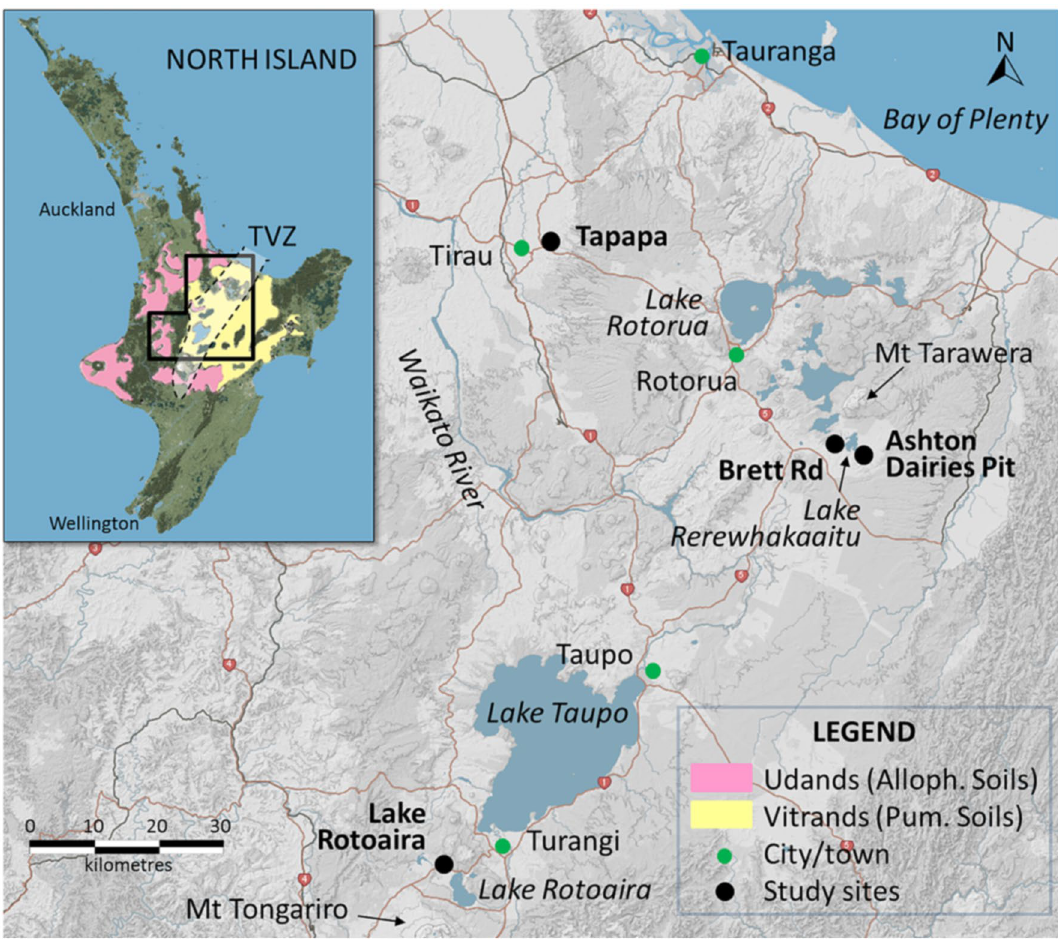
Figure 2. Map of central North Island, New Zealand, showing the locations of the four study sites in the Taupo- Rotorua region. The inset map shows the distribution of Andisols, mainly Udands (equivalent to Allophanic Soils in Hewitt 44 ) and Vitrands (equivalent to Pumice Soils in Hewitt 44 ), and the location of Taupo Volcanic Zone (TVZ) encompassing the volcanoes or volcanic centres that erupted the parent tephras of the soils and paleosols under study 16,17,24 . The maps were derived from the S-map Online (http:// smap. landc arere search. co. nz/ home) and are licensed under CC BY-NC-ND 3.0 NZ, and the maps were modified for the indications of TVZ and study sites. State highways are numbered (red